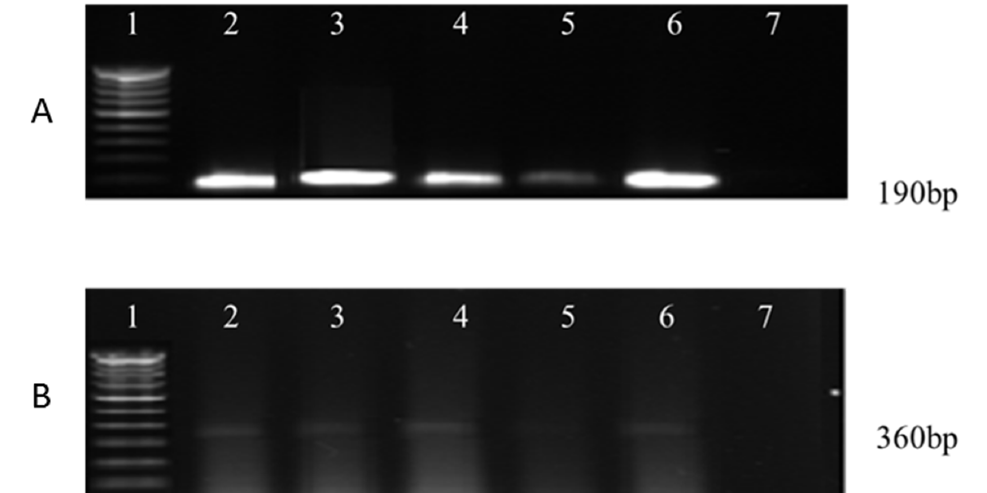
Figure 1. Gel image illustrating the semi-quantitative RT-PCR of nif H gene transcripts. Lane 1: 100 bp DNA marker, Lane 2 to 6: 16S rDNA (A) and nif H gene (B) of isolated strains N2, S10, N2, N8 and N11 respectively, Lane 7: negative control